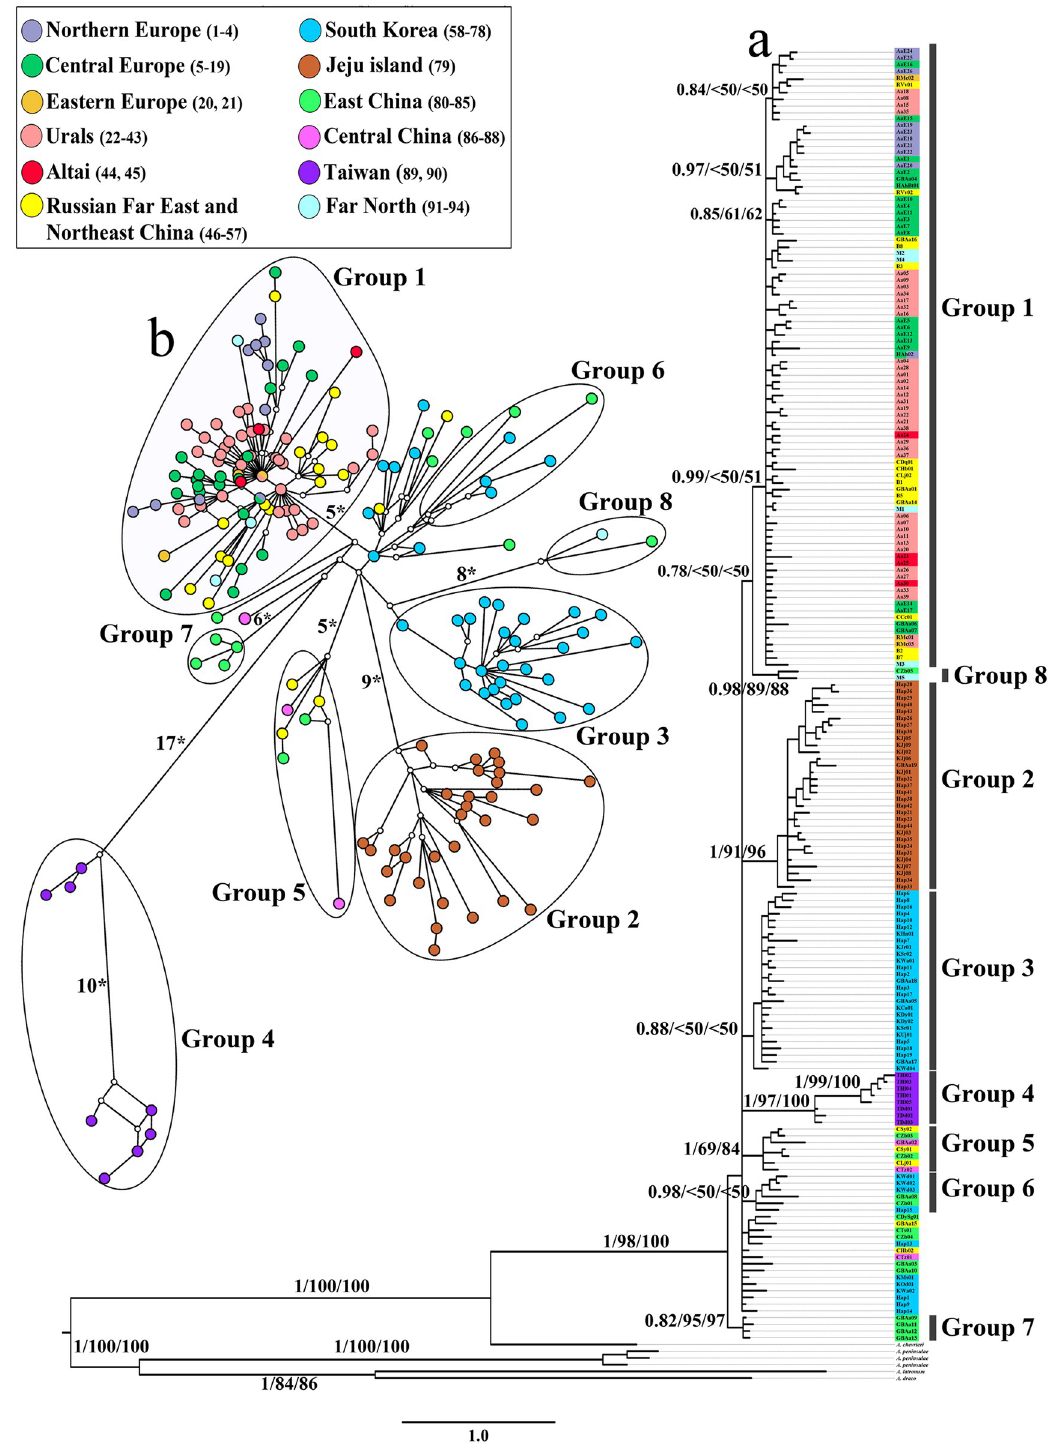
Fig 2. (A) A . agrarius phylogenetic tree constructed using the Bayesian analysis on the basis of 192 haplotypes of cyt b (1140bp ). Near the branches are the BI > 0.70/ML > 50/NJ > 50 probabilities. (B) Median-joining network of cyt b haplotypes. Figures near the branches designate the numbers of substitutions. The colors correspond to those given on the Fig